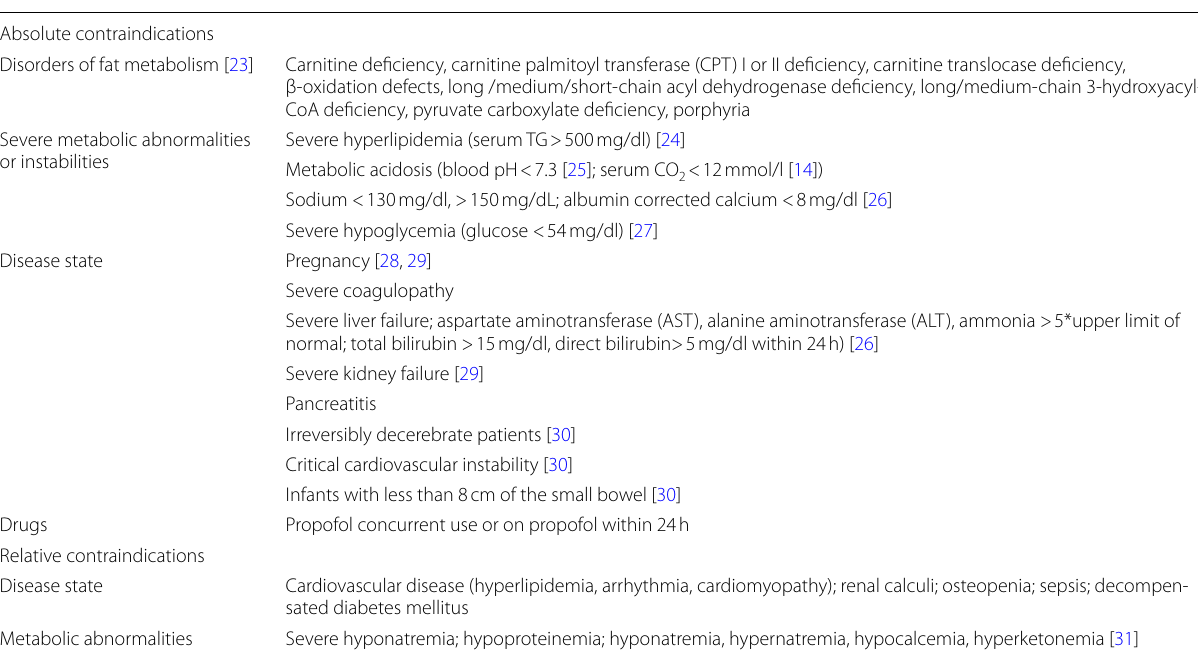
Table 1 Contraindications to the use of KD-PN Absolute contraindications Disorders of fat metabolism [23]